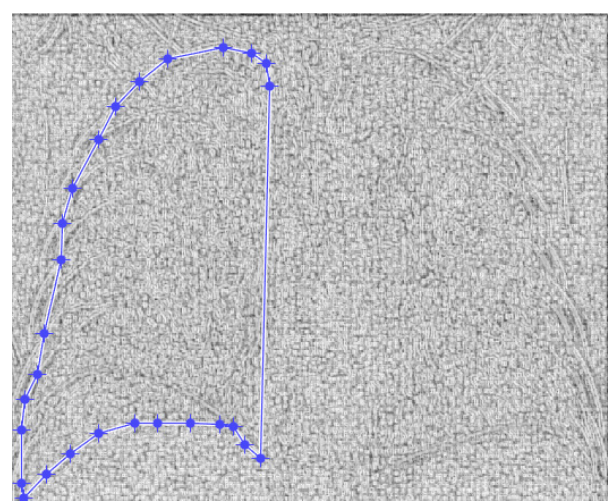
Figure 4. De fi ning the mask for the left lung of the fi rst patient. Figure 4. Defining the mask for the left lung of the first patient.